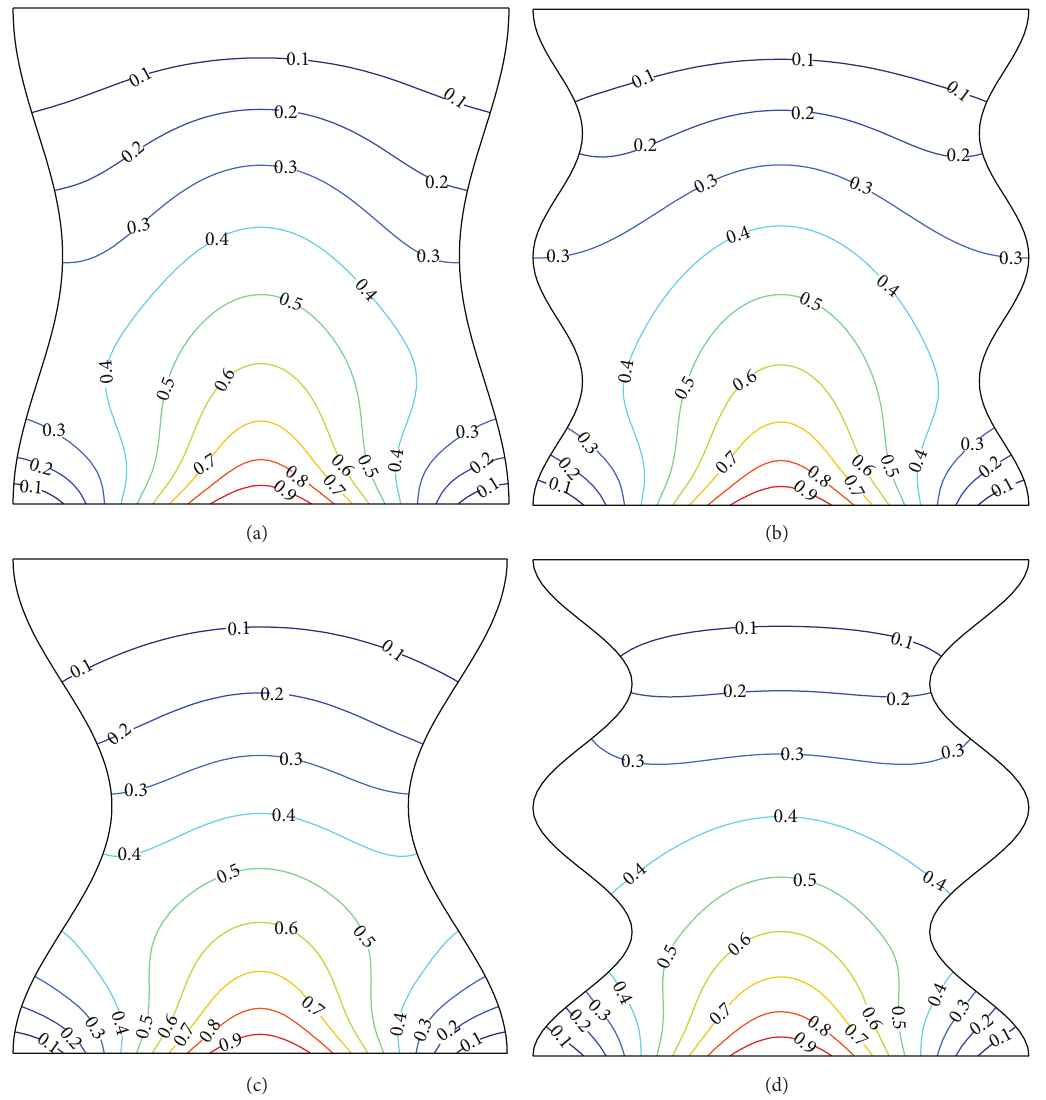
Figure 3: Isotherms ( 𝜃 ) for (a) 𝑛 = 1 , 𝜆 = 0.05 , (b) 𝑛 = 2 , 𝜆 = 0.05 , (c) 𝑛 = 1 , 𝜆 = 0.1 and (d) 𝑛 = 2 , 𝜆 = 0.1 .